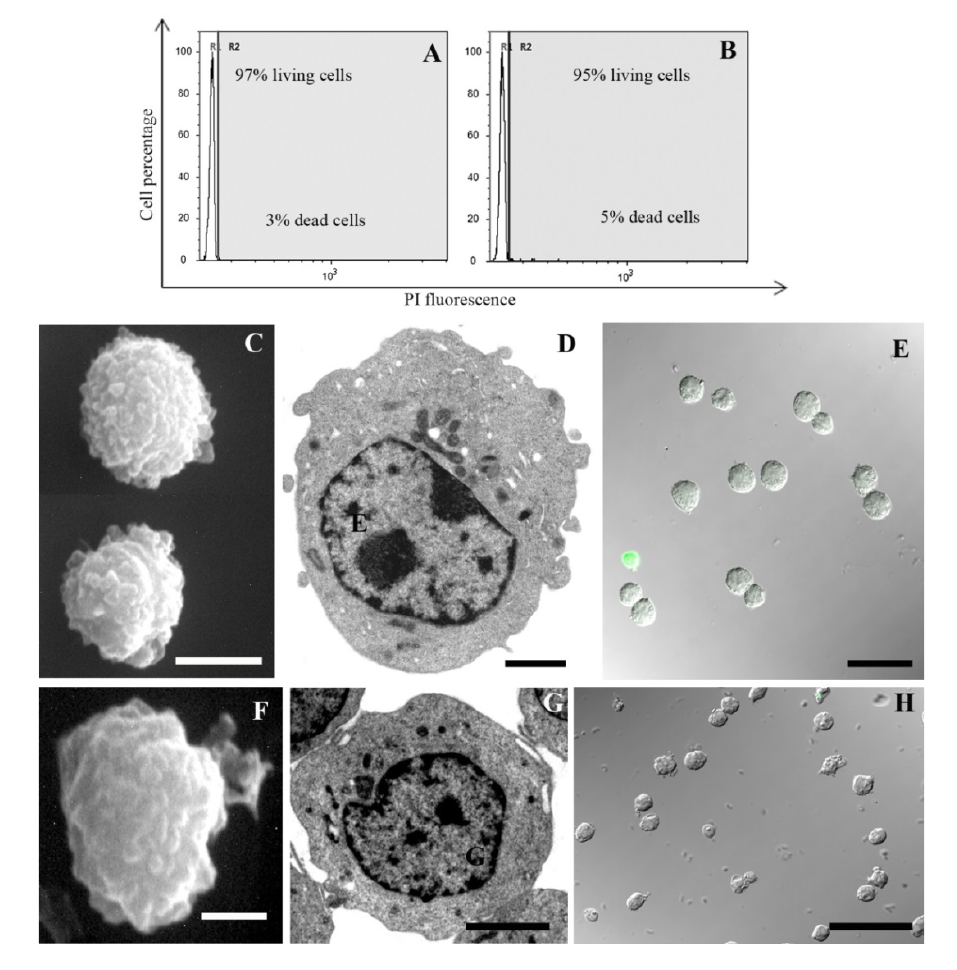
Figure 1. Control ( A , C – E ) and MEL alone ( B , F – H ) treated cells analysed by means of supravital PI ( A , B ), SEM ( C , F ), TEM ( D , G ) and CLSM ( E , H ) reveal a negligible